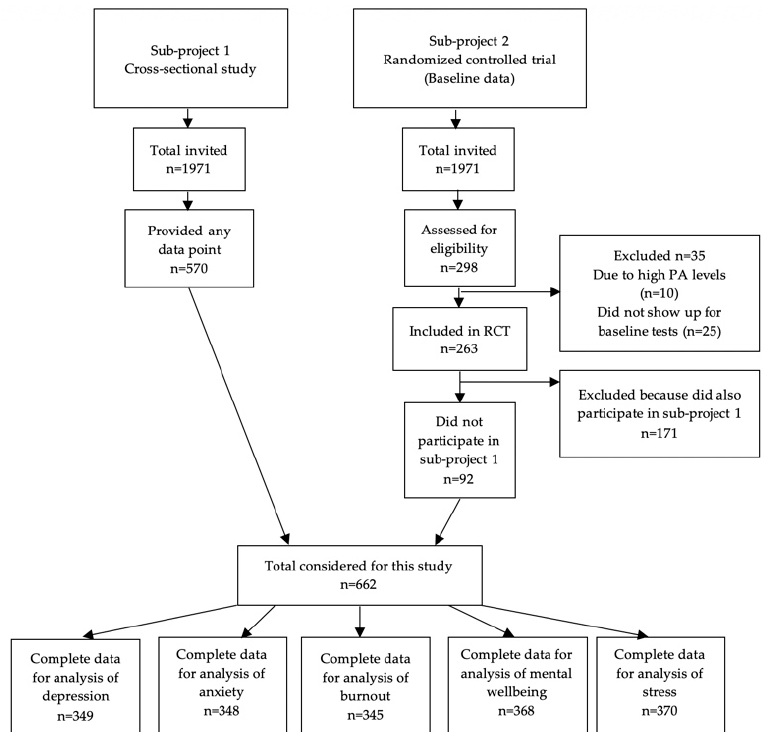
Figure 1. Flow-chart of the number of participants included from the two projects.